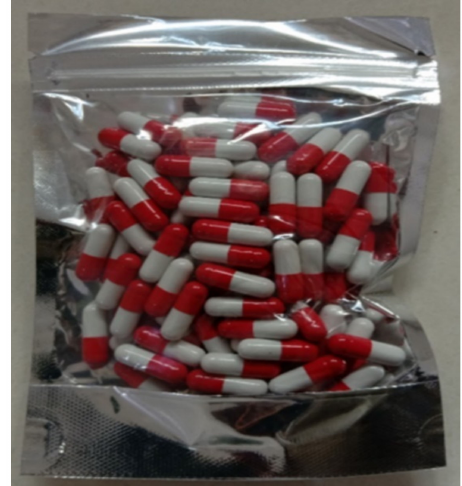
Figure 3. Blister bag containing 100